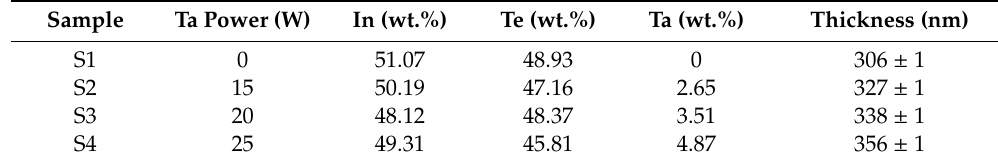
Figure 4. The cross-sectional SEM images of ( a ) S2 and ( b ) S3. Table 3. The composition and thickness results of Ta-doped InTe thin